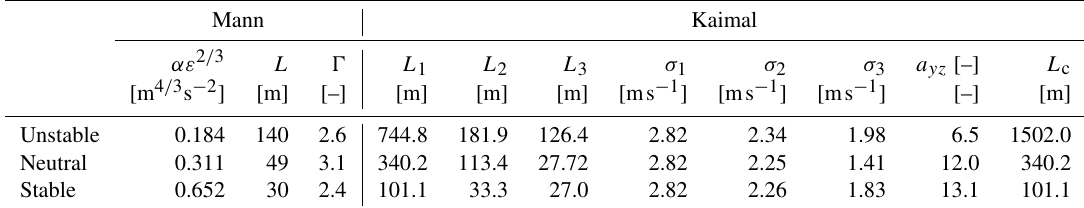
Table 1. The Mann model parameters under different atmospheric stability classes (based on the work of Peña, 2019) and the fitted Kaimal model parameters, calculated using a mean wind speed of 16ms − 1 . αε 2 / 3 is scaled such that the TI corresponds to the IEC 61400-1:2019 (2019) class 1A definition. Mann Kaimal